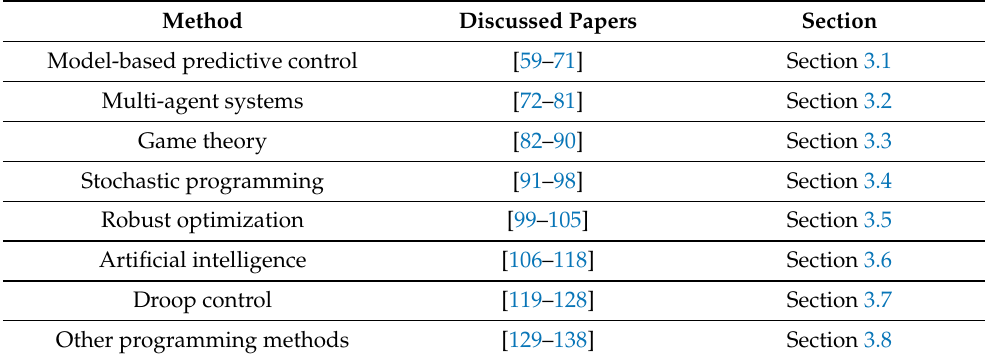
Figure 3. MG management vs. NMG management with a focus on years 2011, 2016 and 2021. The re- search papers considered here—these papers deal with different aspects of MG/NMG management— are published in peer-reviewed journals owned by the leading publishers of scientific content. Table 2. Discussed papers highlighting recent advances in MG/NMG management, according to the method used (see Section